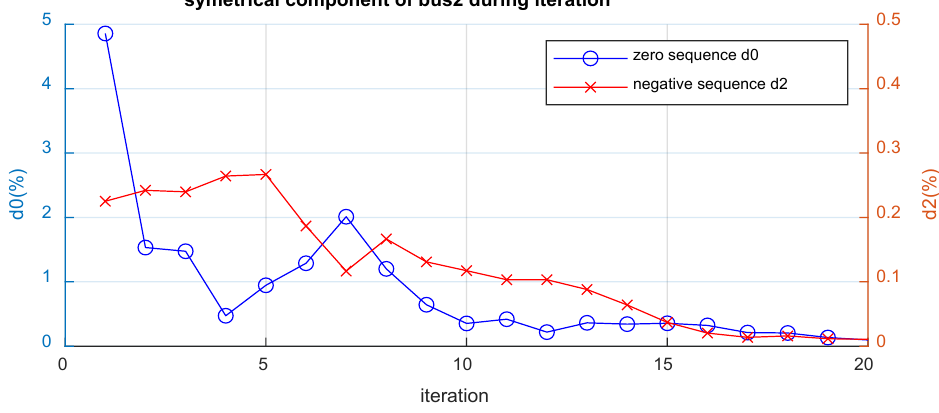
Figure 5. Minimum fitness functions during iterations in Case A.